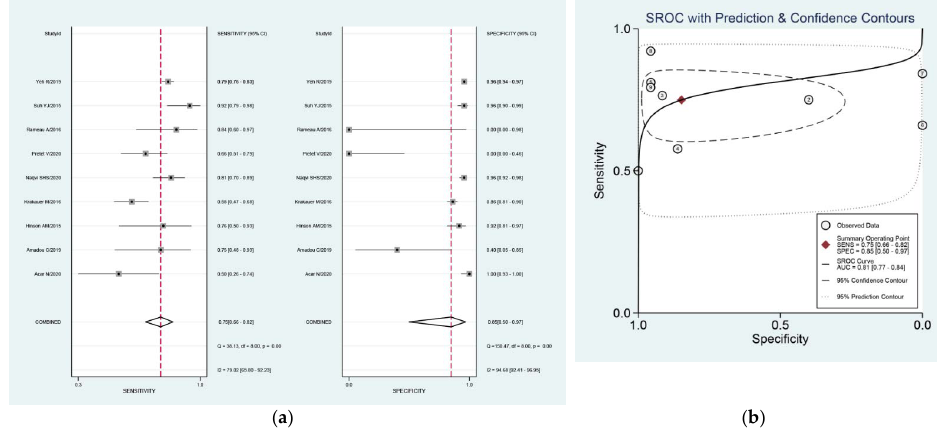
Figure 3. ( a ) Forest plot of pooled sensitivity and specificity and ( b ) summary receiver-operating characteristic (ROC) curves of four-dimensional computed tomography (4D-CT) for assessing localization of hyperfunctioning parathyroid glands (HPGs) in primary hyperparathyroidism (pHPT) patients on a per-lesion level. The area under the ROC curves of 4D-CT was 0.81. Subgroup analyses, performed by imaging procedure, revealed that four studies used 4D-CT as a second-line examination, and this resulted in a pooled sensitivity and specificity of 65% (95%CI: 54–75%) without significant heterogeneity (I 2 = 22%, Q = 3.84) and 78% (95%CI: 3–100%) with significant heterogeneity (I 2 = 94.9%, Q = 58.9). On the other